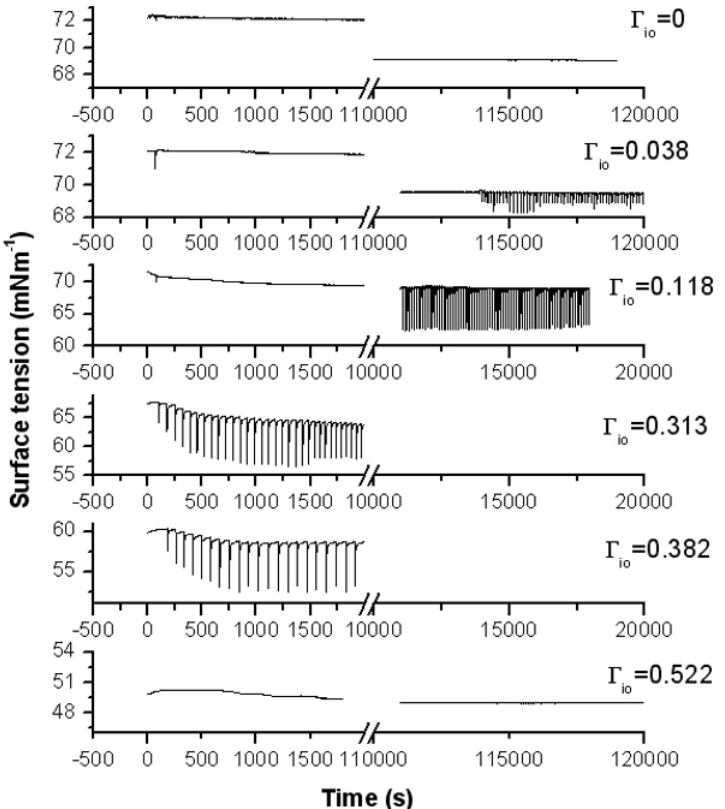
Figure 16. Dynamic regimes by dissolution of a heptanol droplet in the presence of a spread monolayer of DMPC (L- α -phosphatidylcholine, dimyristoyl), the initial surface coverage is shown on the curves, the vessel diameter d=75 mm, the capillary immersion depth h=1 mm (reprinted from [35], with permission from